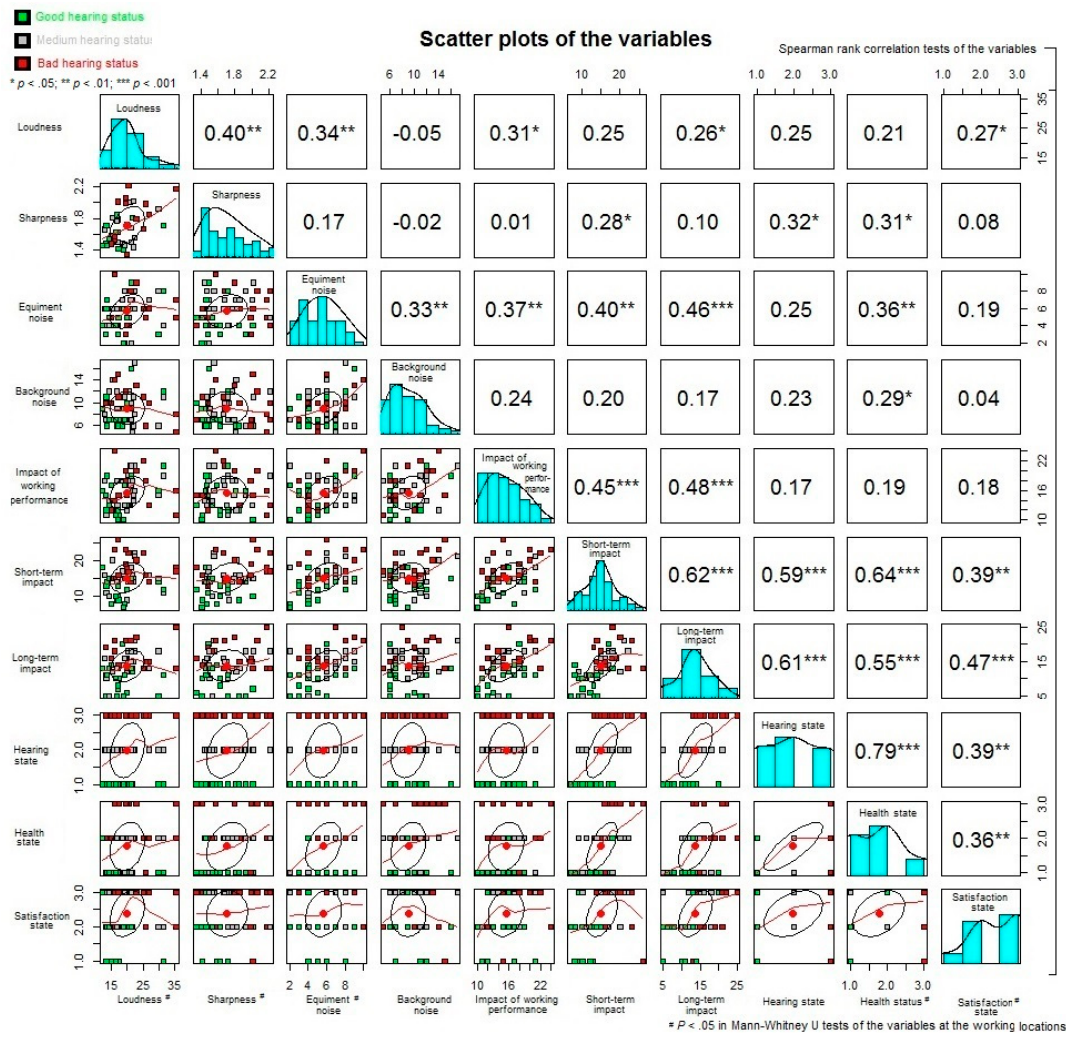
Figure 4. A summarized plot of the bivariate correlation test results of the variables. * p < 0.05, ** p < 0.01, *** p < 0.001.